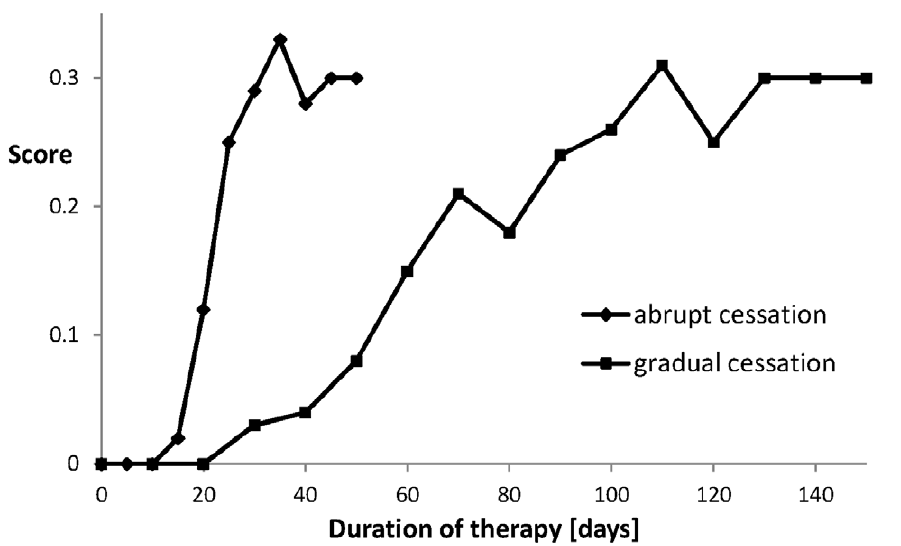
Figure 5. Scores for two types of cessation strategies as described in the text. The vertical axis give the fraction of successes out of 100 realisations. Success means that during one year after ending the therapy the person has a nicotine intake that stays below 5% of the intake before the therapy.